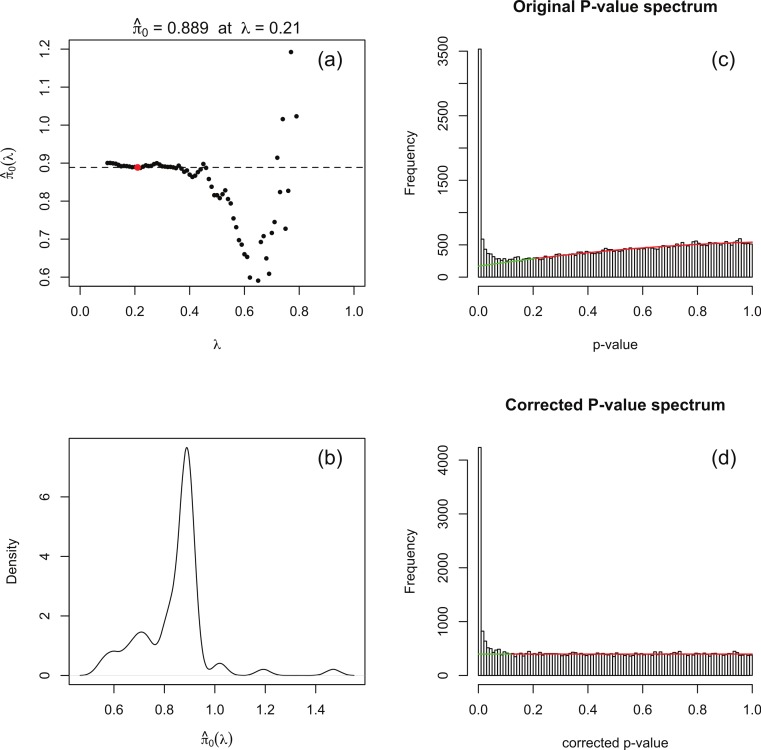
(A) Estimates of the fraction π0 of genes not DE obtained by fitting a quadratic function to the original input (without the flagpole) p-value histogram over the interval [λ, 1]. (B) Density plot of obtained estimates \documentclass[12pt]{minimal}
\usepackage{amsmath}
\usepackage{wasysym}
\usepackage{amsfonts}
\usepackage{amssymb}
\usepackage{amsbsy}
\usepackage{upgreek}
\usepackage{mathrsfs}
\setlength{\oddsidemargin}{-69pt}
\begin{document}
}{}${\hat {\pi }}_{0}$\end{document}πˆ0. The optimal λopt (red dot in (A)) is obtained by choosing the \documentclass[12pt]{minimal}
\usepackage{amsmath}
\usepackage{wasysym}
\usepackage{amsfonts}
\usepackage{amssymb}
\usepackage{amsbsy}
\usepackage{upgreek}
\usepackage{mathrsfs}
\setlength{\oddsidemargin}{-69pt}
\begin{document}
}{}${\hat {\pi }}_{0}(\lambda )$\end{document}πˆ0λ closest to the mode of the \documentclass[12pt]{minimal}
\usepackage{amsmath}
\usepackage{wasysym}
\usepackage{amsfonts}
\usepackage{amssymb}
\usepackage{amsbsy}
\usepackage{upgreek}
\usepackage{mathrsfs}
\setlength{\oddsidemargin}{-69pt}
\begin{document}
}{}${\hat {\pi }}_{0}$\end{document}πˆ0 density. The mode is also indicated by the dotted line in (A). The original and corrected p-value histograms are shown in (C) and (D), together with optimally fitted quadratic in (C) and its image after correction in (D). The red part of the quadratic is the interval [λopt, 1] in (C) and its image in (D). This example is generated from synthetic data for which the true value of π0 is 0.85.